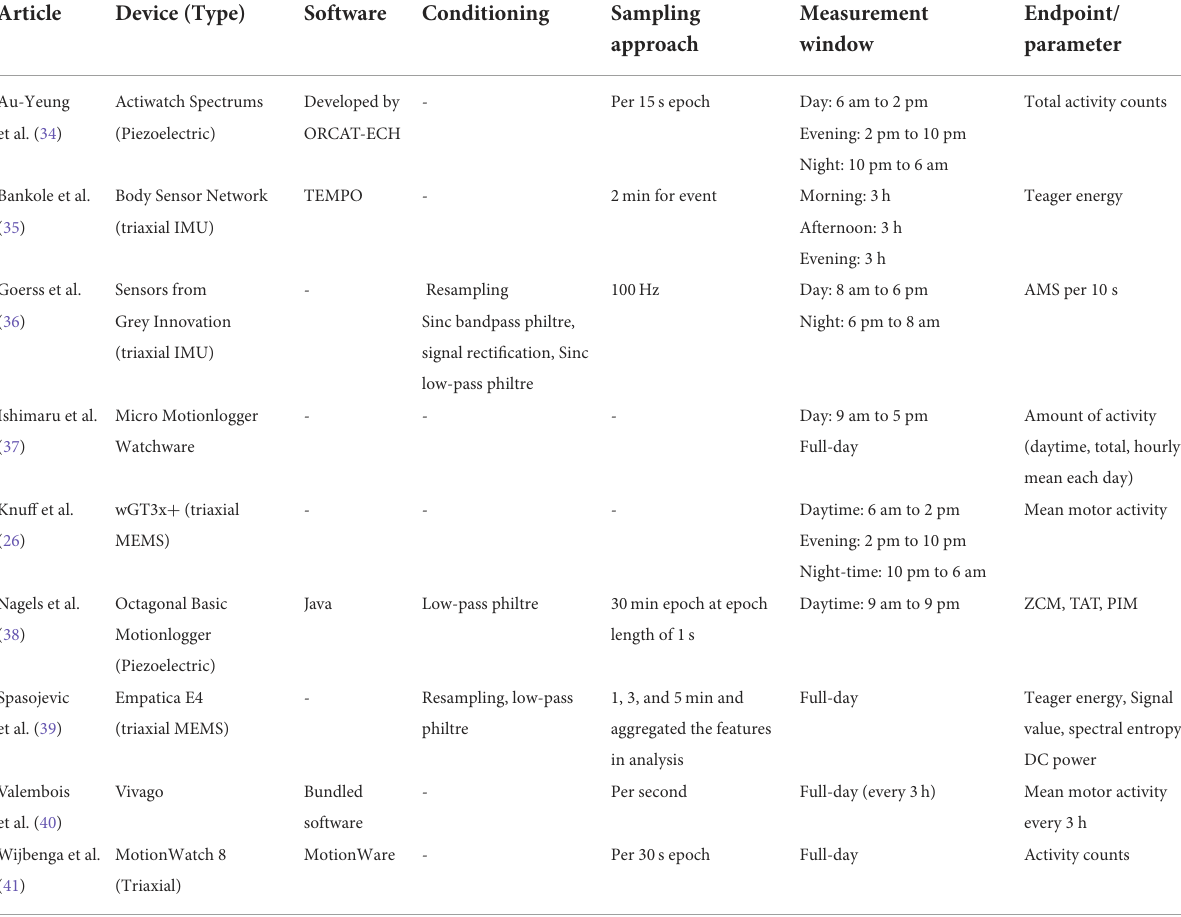
TABLE 2 Accelerometer specification, data conditioning, and